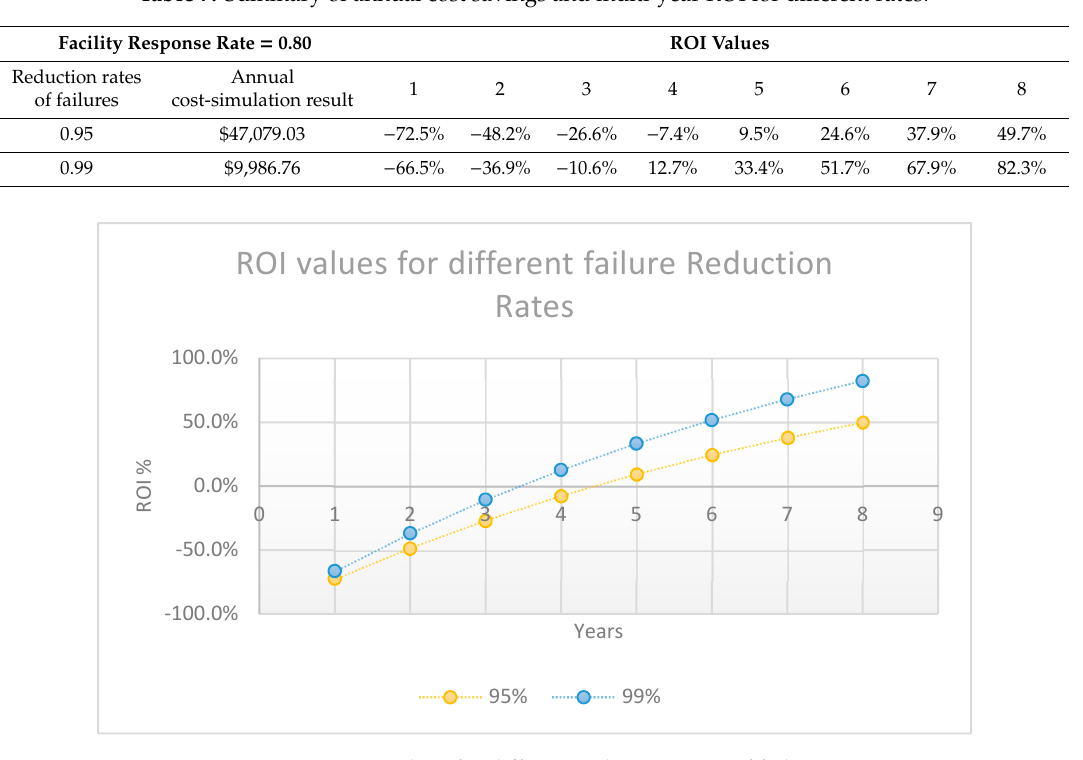
ff erent reduction rates of Figure 14. ROI values for different reduction rates of failures. Figure 14. ROI values for di